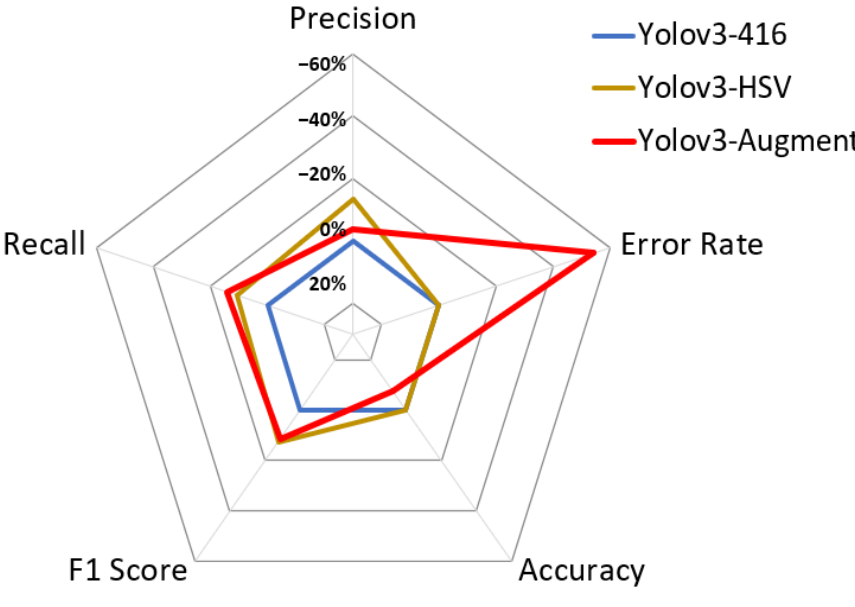
Figure 17. Relative performance comparison of the AI models (relative ratio units: %).